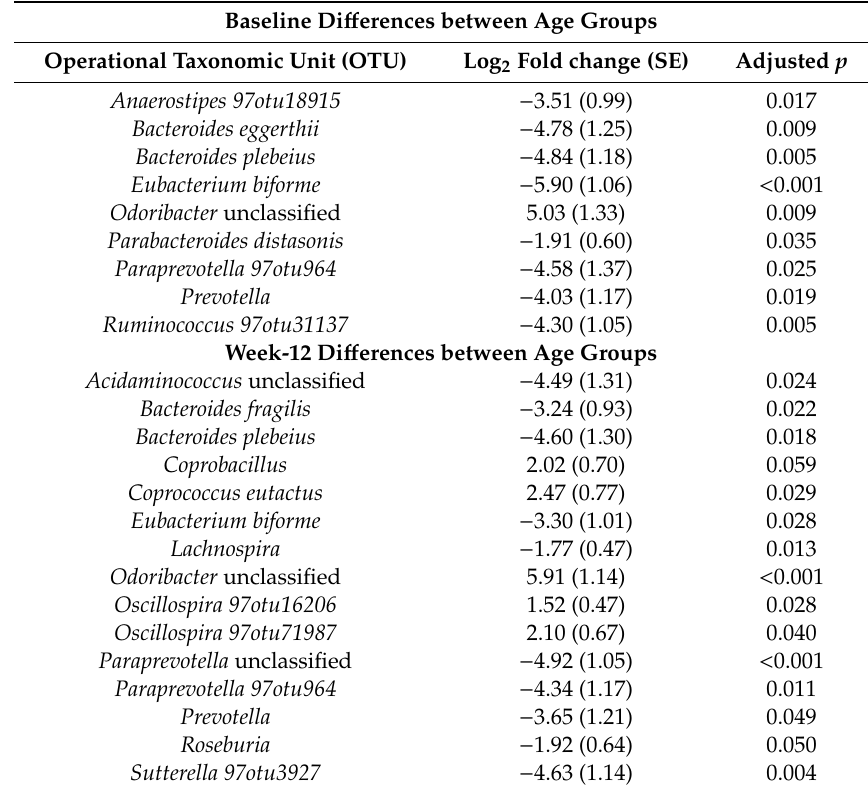
Table 6. Di ff erential microbial abundance related to age.